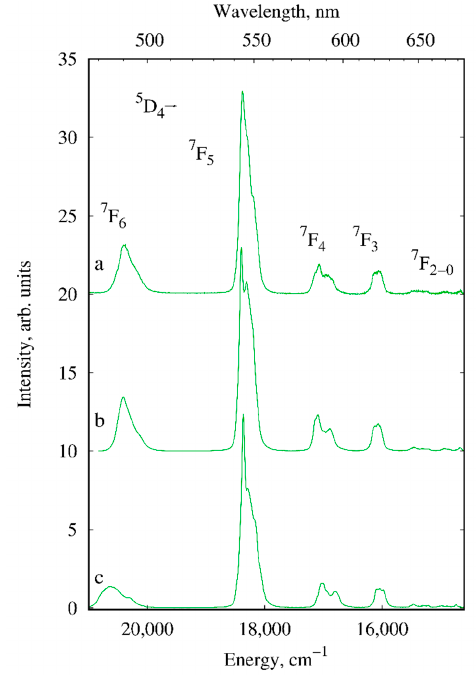
Figure 6. Luminescence spectra of III ( a ), V ( b ) and VIII ( c ) (solid samples, λ ex = 280 nm, T = 300 K).